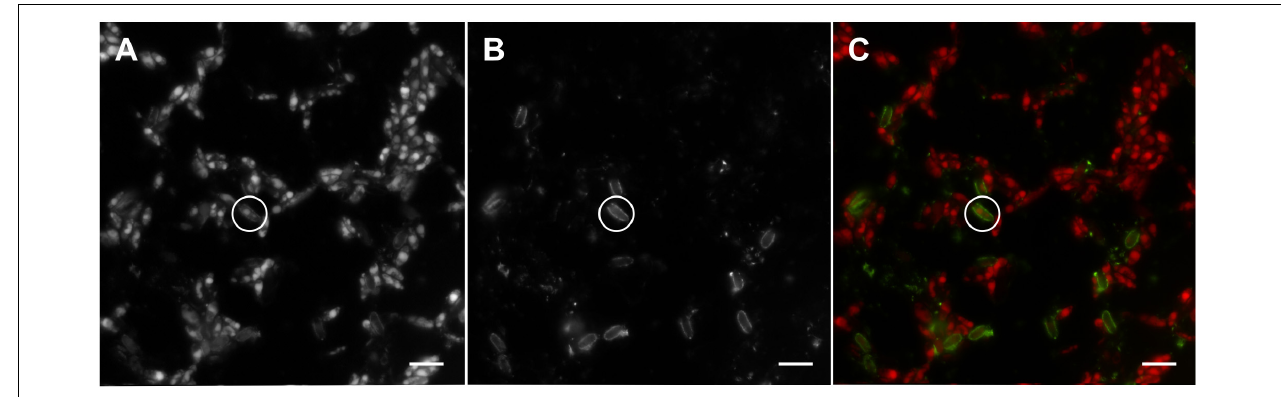
FIGURE 1 | A set of epifluorescence microphotographs of the Coccomyxa elongata culture with induced extracellular phosphatase activity grown in P-depleted organic medium (O3). Same image areas show: (A) the image captured with chlorophyll-autofluorescence-specific filter cube (excitation/emission: 510–550 nm/ > 590 nm) visualizing single algal cells; (B) the image captured with ELFA-fluorescence-specific filter cube (excitation/emission: 360–370 nm/520–540 nm) visualizing fluorescence-labeled enzyme activity (FLEA), i.e., the ELFA precipitates on surfaces of phosphatase-positive cells; and (C) the merged images A and B in artificial colors – red and green stand for chlorophyll autofluorescence and ELFA fluorescence, respectively. Circles indicate the same phosphatase-active cell; scale bars represent 10 µ m.